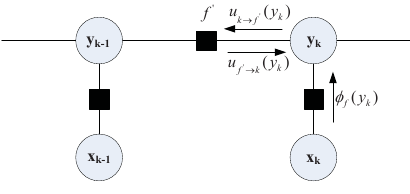
Figure 2: Belief propagation between hidden vari- able where ψ is a constant and m ( x ) =